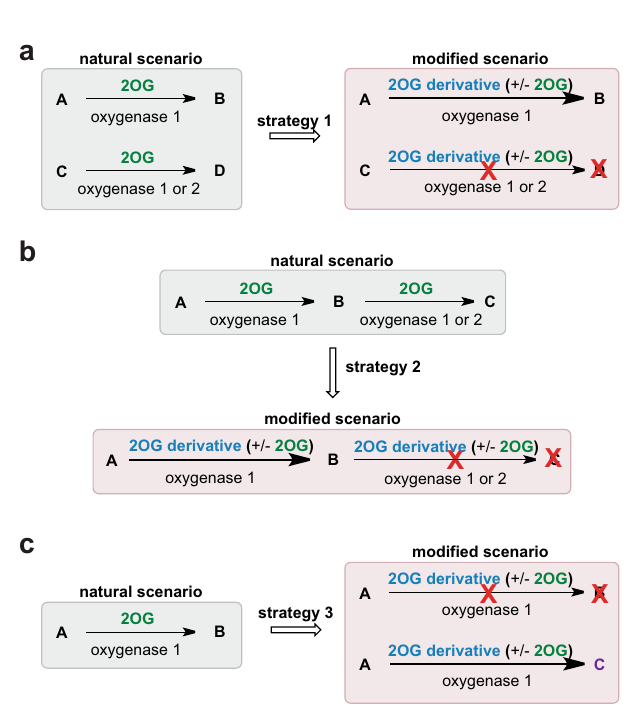
Fig. 6 2OG derivatives may be used to selectively control reaction outcomes of 2OG oxygenase catalysis. Each enzyme reaction involves two-electron substrate oxidation coupled to the conversion of 2OG/O 2 to succinate/CO 2 . The substitution of 2OG by a 2OG derivative or the addition of an inhibitory 2OG derivative has the potential to alter natural reaction outcomes of one or multiple 2OG oxygenase reactions. For example, it may enable the selective enhancement/inhibition of catalysis by one 2OG oxygenase in the presence of another/others ( a strategy 1), the perturbation of sequential 2OG oxygenase reactions ( b strategy 2), or the formation of different reaction products in a 2-oxo acid cosubstrate- dependent manner ( c strategy 3).